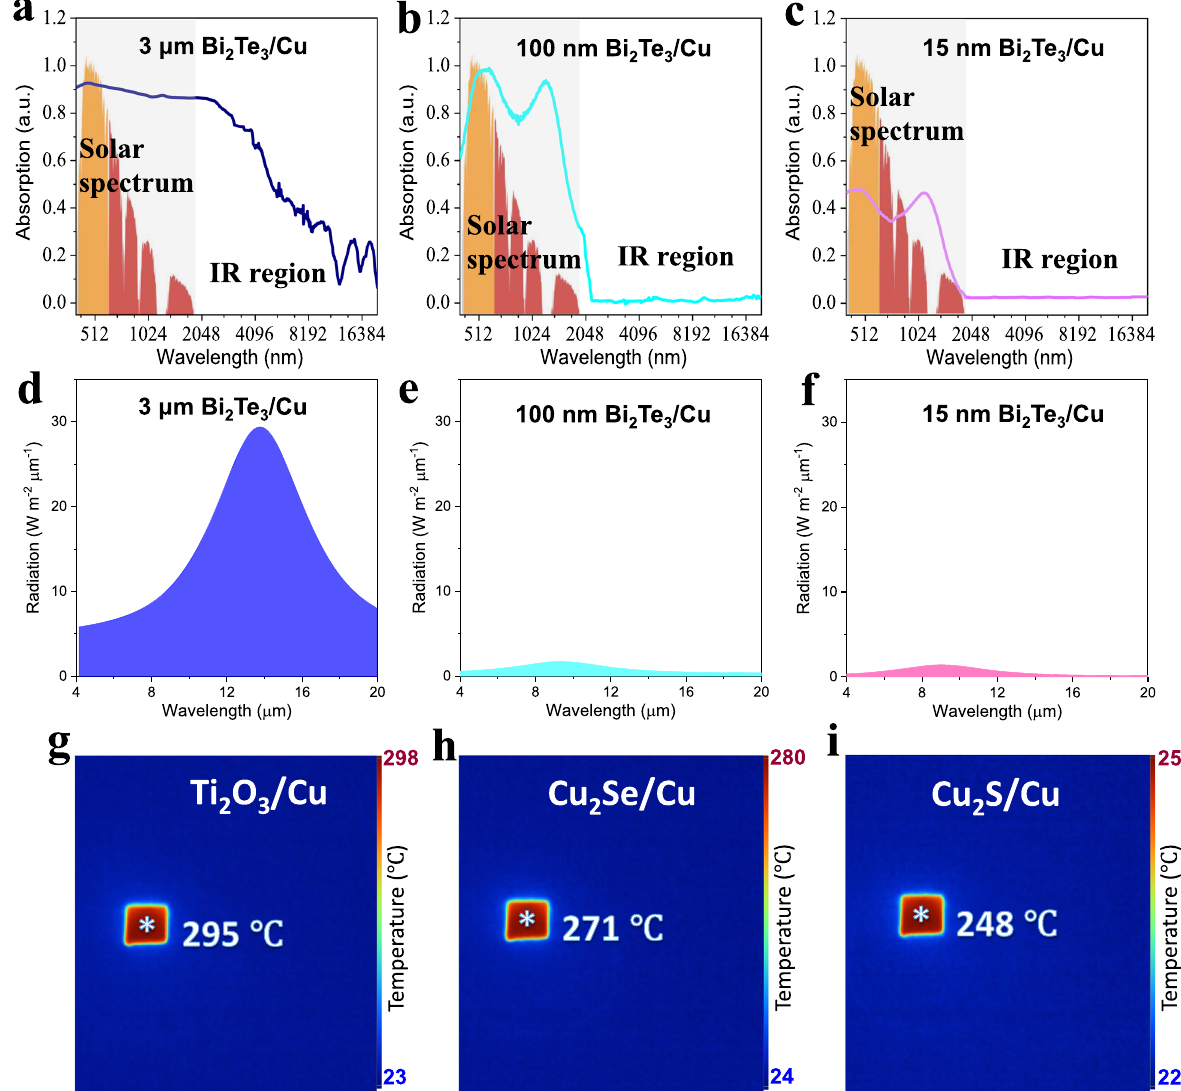
Fig. 2 Thickness effect and universality of the heterostructure strategy. a – c Normalized light absorption spectra of Bi 2 Te 3 /Cu with 3 μ m-, 100 nm-, and 15 nm-thick Bi 2 Te 3 layers. d – f IR radiation ranging from 4 μ m to 20 μ m for Bi 2 Te 3 /Cu with 3 μ m-, 100 nm-, and 15 nm-thick Bi 2 Te 3 layers at 93 °C. g – i IR images of vacuum-protected Ti 2 O 3 /Cu, Cu 2 Se/Cu, Cu 2 S/Cu heterostructures. A CaF 2 glass fully covered each sample, and the vacuum degree of this equipment was 1.0 × 10 − 3